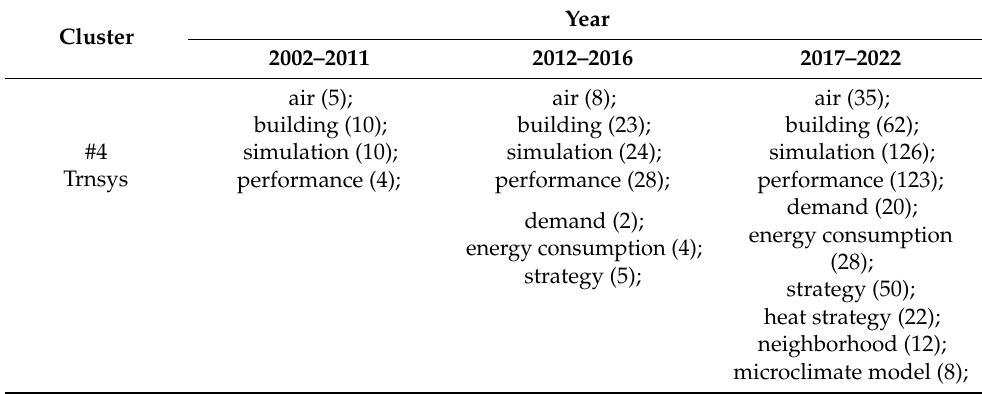
Table 3. Cont. Cluster